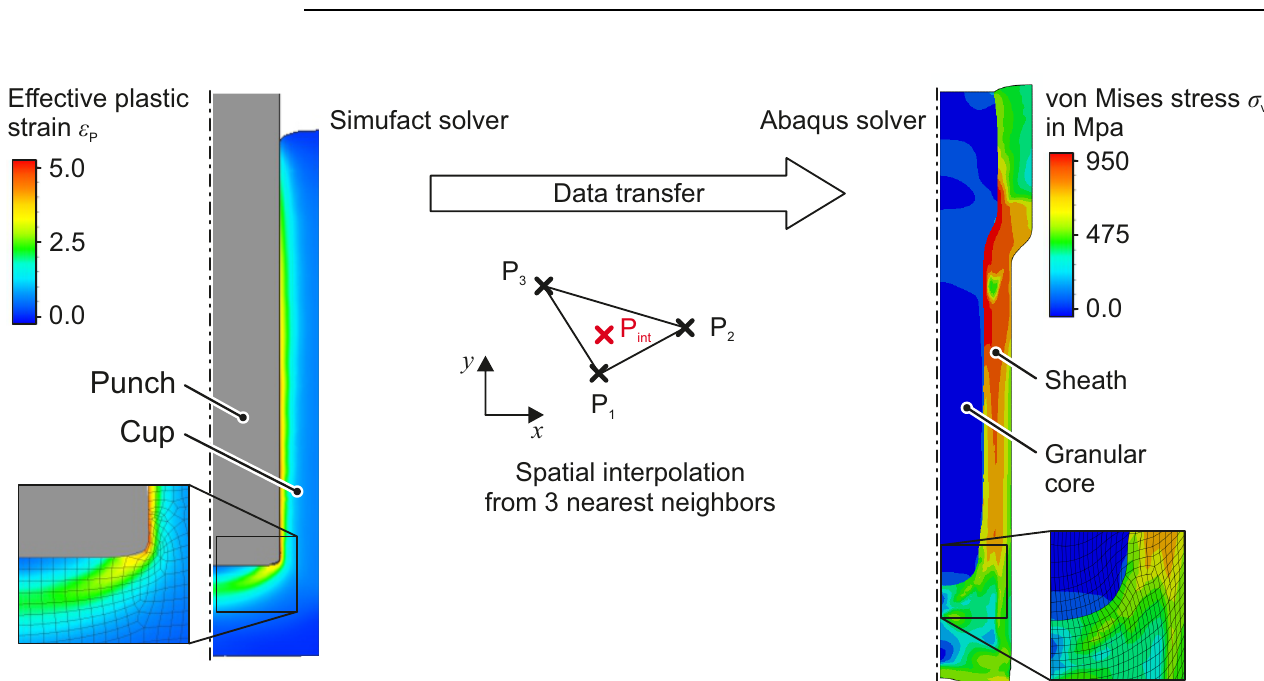
Figure 15. Simulation model for the process chain of cold forging with granular medium based cores. Backward can extrusion is modelled using Simufact forming. The process step of forward rod extrusion is modelled using Abaqus. The data transfer between the two solvers is implemented by a Python